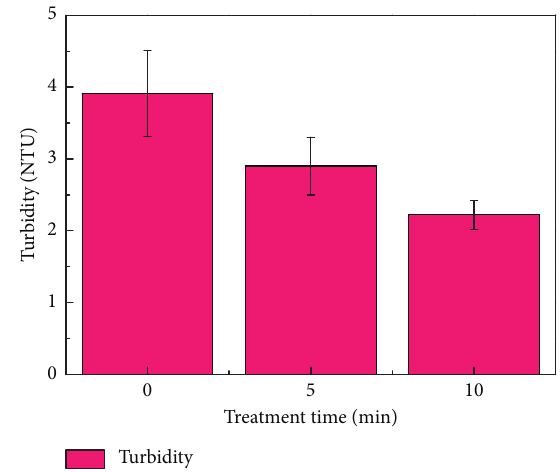
Figure 18: Variation of turbidity with treatment time (5kV, 19.56kHz, and